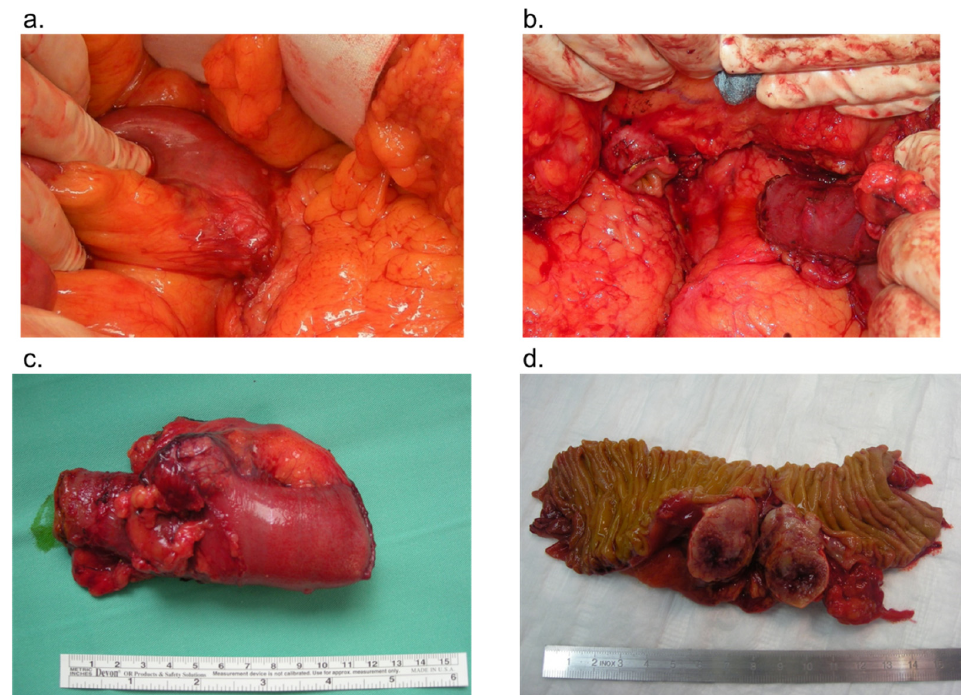
Figure 1. Intraoperative finding of duodenal GIST originating from the third portion of duodenum ( a ). Limited resection of duodenal GIST in terms of segmental duodenectomy ( b ). Specimen of duodenal GIST ( c ). Macroscopic appearance of duodenal GIST with outward growth and a centrally ulcerated umbilication ( d ).